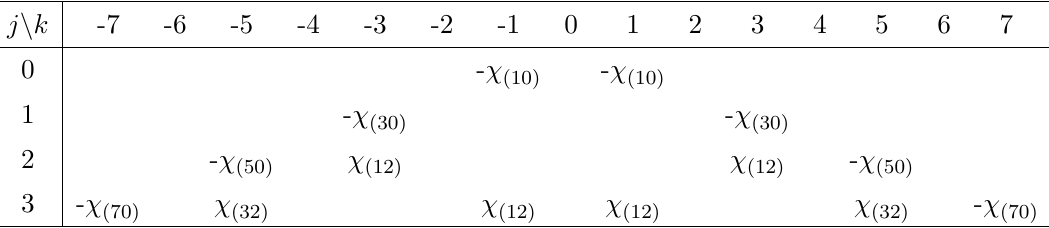
( m ) in the series expansion of (cid:24) 1 ; Sp(2) v , written in Sp(2) j;k = (cid:31) Sp(2) ( m ( n 1 n 2 ) Sp(2) ( n 1 n 2 )